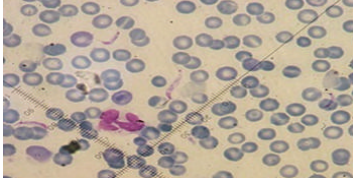
Figure 1: Trypanosoma lewisi in blood smear of the studied rodents, stained with Giemsa